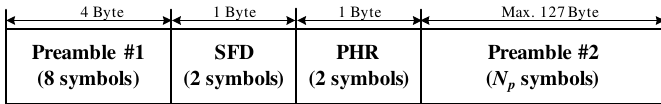
Figure 2. Packet structure for time of arrival (TOA) estimation. SFD: start-of-frame delimiter; PHR: PHY header.